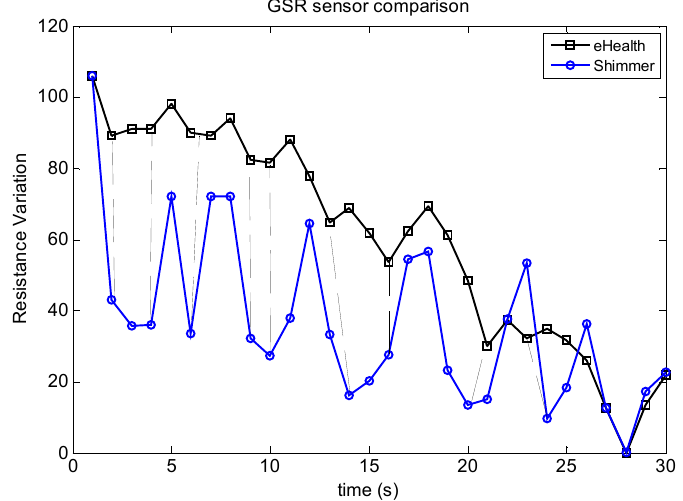
Figure 11. Comparison of the Libelium and the Shimmer GSR sensors behavior on the same person. The vertical dashed lines denote the corresponding local minima between the two sensors.